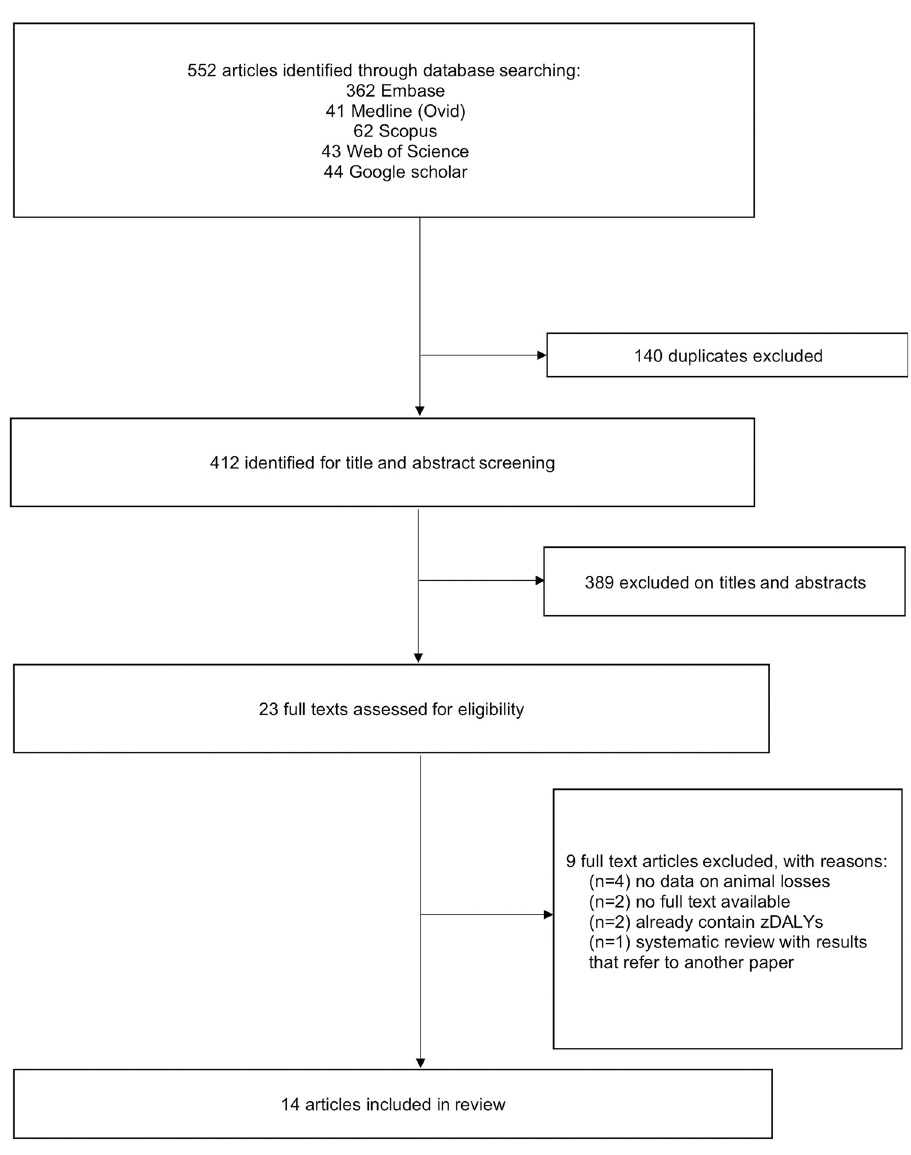
Fig 1. Literature search and article